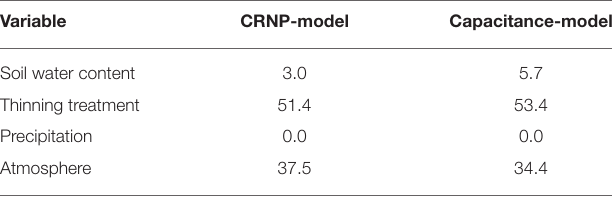
Both models considered the same independent variables (except for rainfall partitioning, estimated for each plot) but used different data for the soil water content: either CRNP-model and